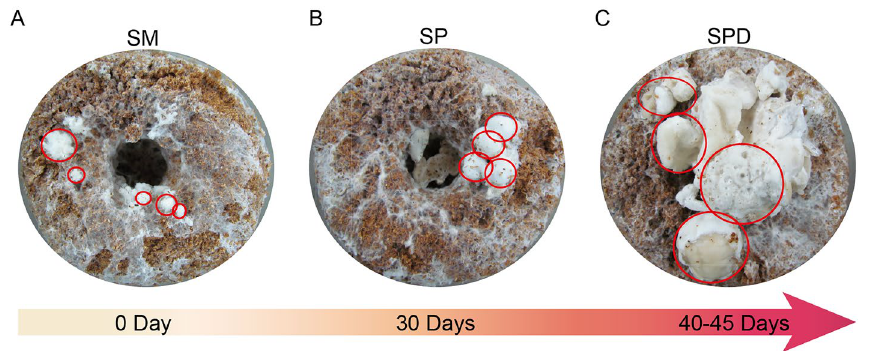
Figure 1. The developmental stages of S. latifolia . ( A ) the hyphal knot (SM); ( B ) primordium (SP); ( C ) primordium differentiation (SPD). The tissues of different stages are marked in red